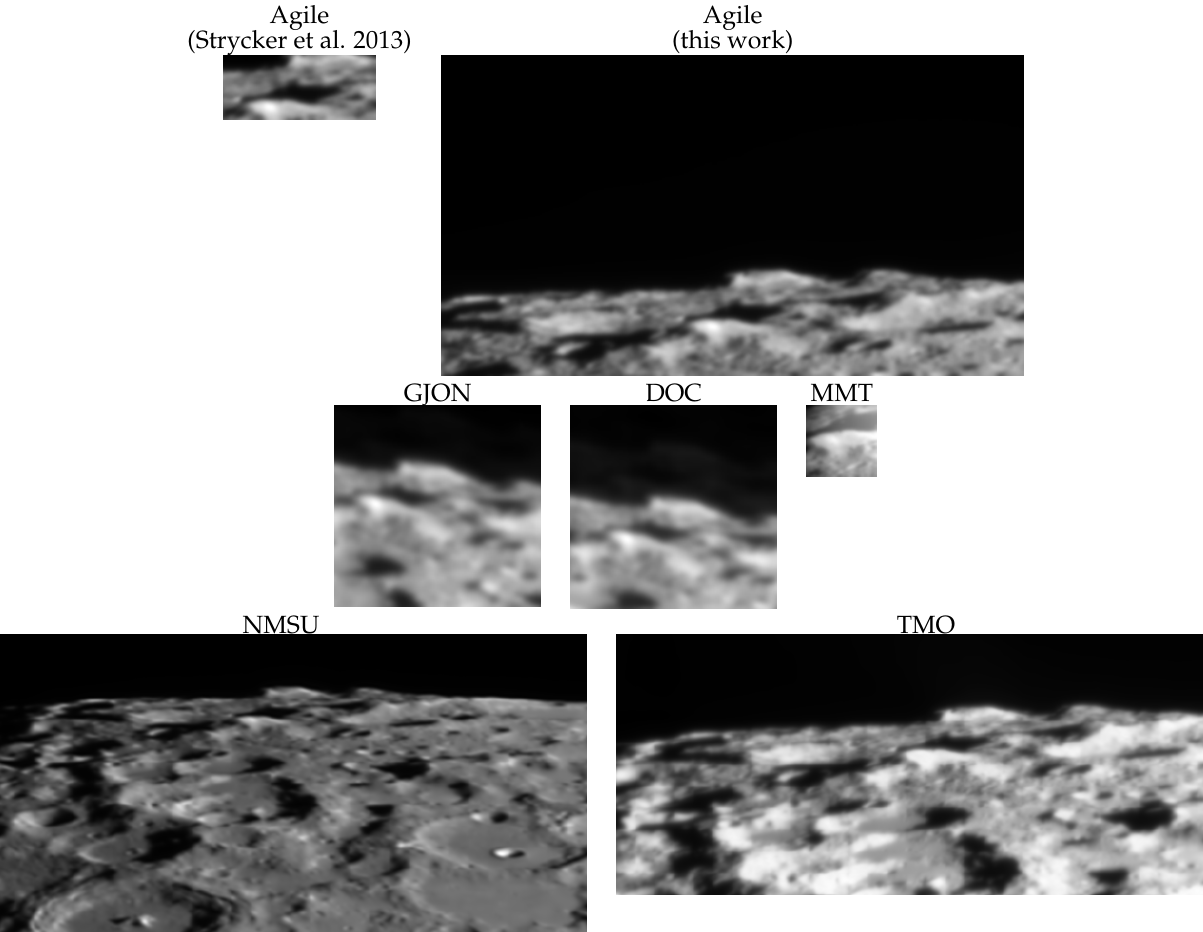
Figure 1. The static lunar landscape for each data set, including the Strycker et al. [13] reduction of Agile data. These are the PC1 pixel amplitudes, which show the typical quality of seeing across each time series but with greatly reduced contamination from noise and geometric